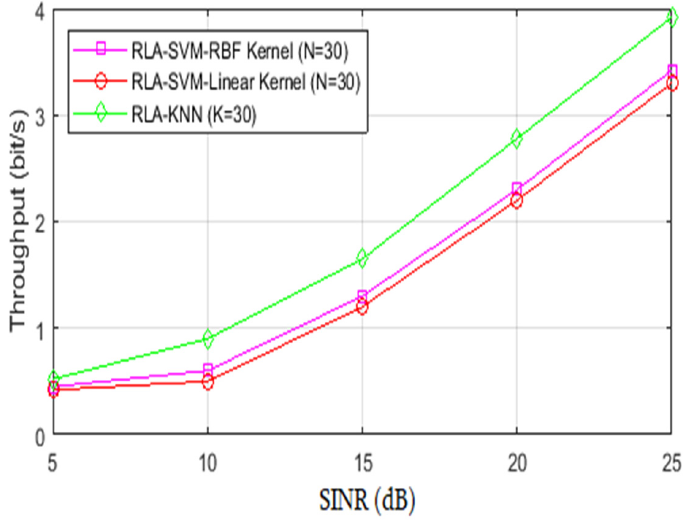
Figure 7. Throughput versus SINR for RLA–SVM–RBF, RLA–SVM–linear, and RLA–KNN.